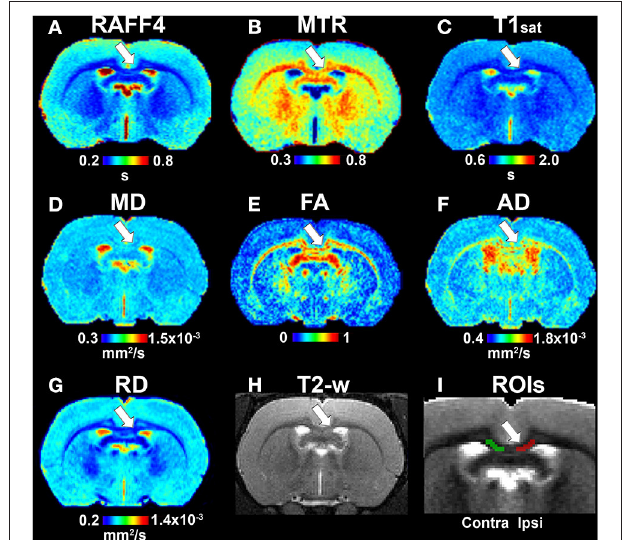
FIGURE 2 | Quantitative MRI maps in the demyelination phase, on day 3: RAFF4 (A) , magnetization transfer ratio, MTR (B) , T1sat (C) , mean diffusivity, MD (D) , fractional anisotropy, FA (E) , axial diffusivity, AD (F) , radial diffusivity, RD (G) , T2w image with lesion (H) and representative example of ROIs for analyzing the lesion on a grayscale RAFF4 map (I) . White arrow points to the lesion in the corpus callosum.